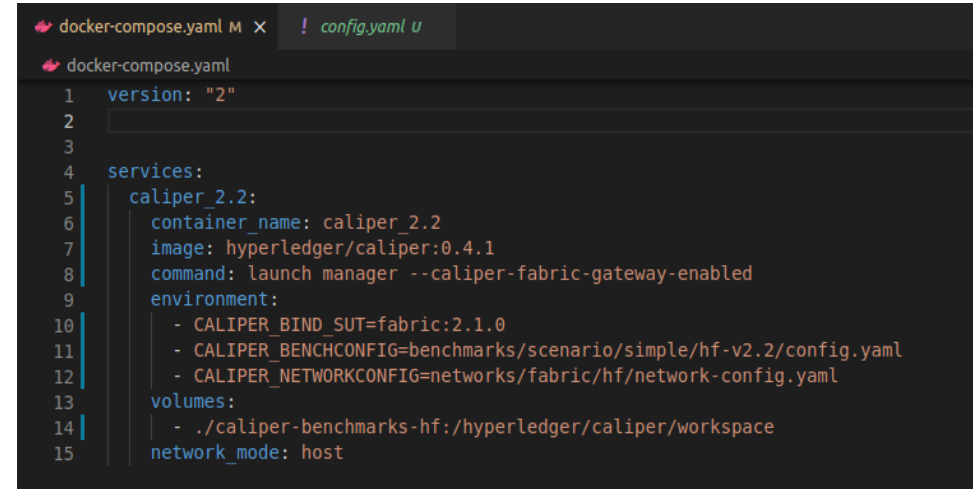
Figure 14. Docker file used for setting up the Hyperledger Caliper.